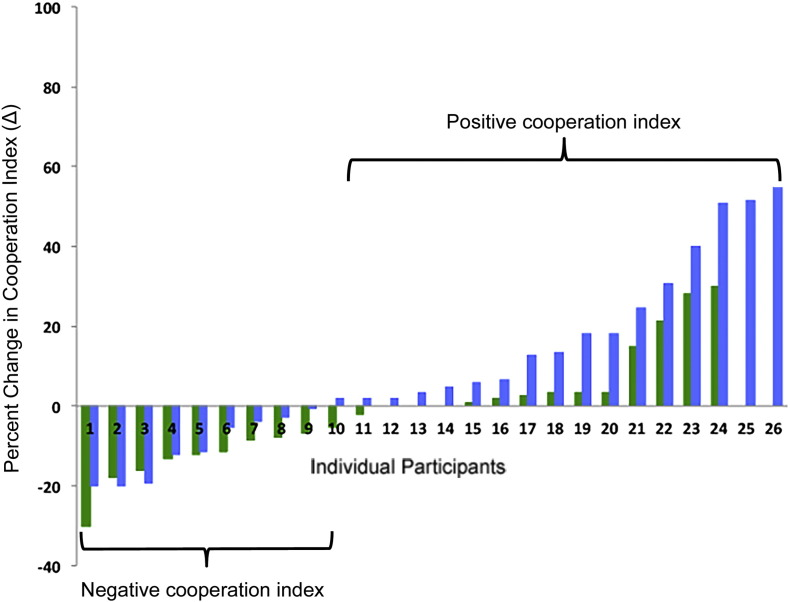
Cooperation index across groups.Blue indicates MT group (n = 26). Green indicates CT group (n = 24). 17 subjects in the MT group displayed a positive cooperation index, whereas this number for the CT group was 10. There were 9 subjects in the MT group who displayed a negative cooperation index and 11 in the in CT group. 3 subjects in the CT group did not display a change in delta.